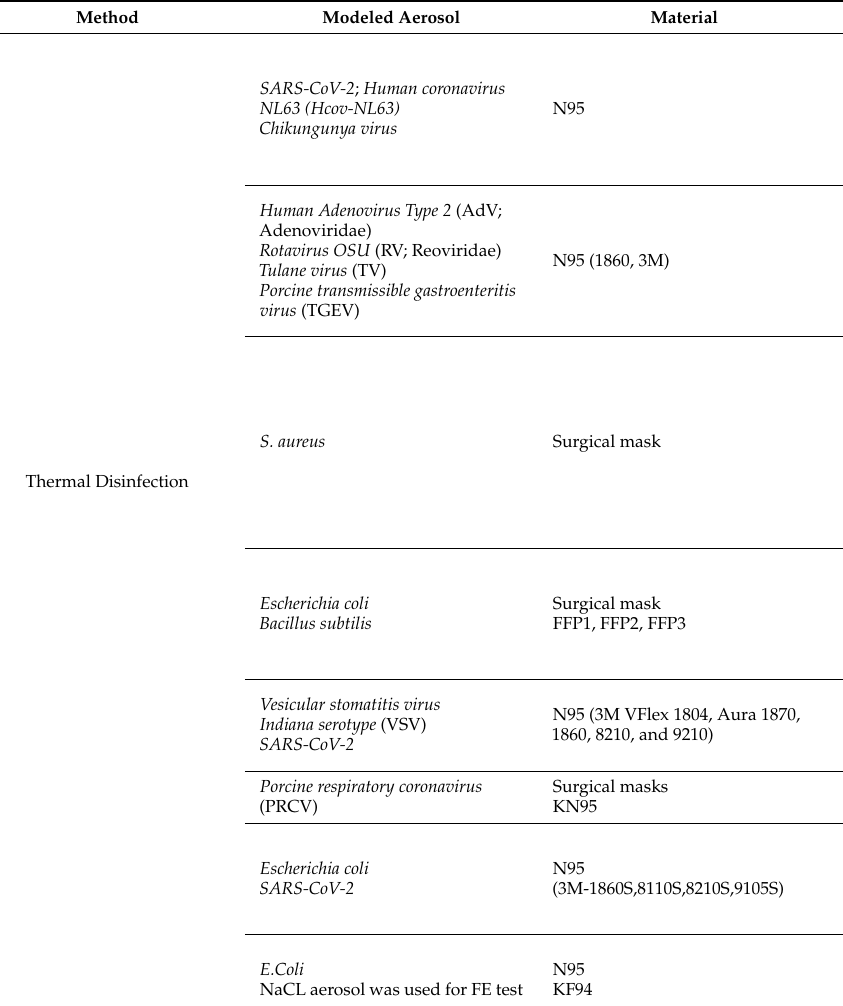
Table 10. Decontamination and regeneration using thermal disinfection (T ≡ Temperature, RH ≡ Relative Humidity, D ≡ Detect, and ND ≡ Not Detect).